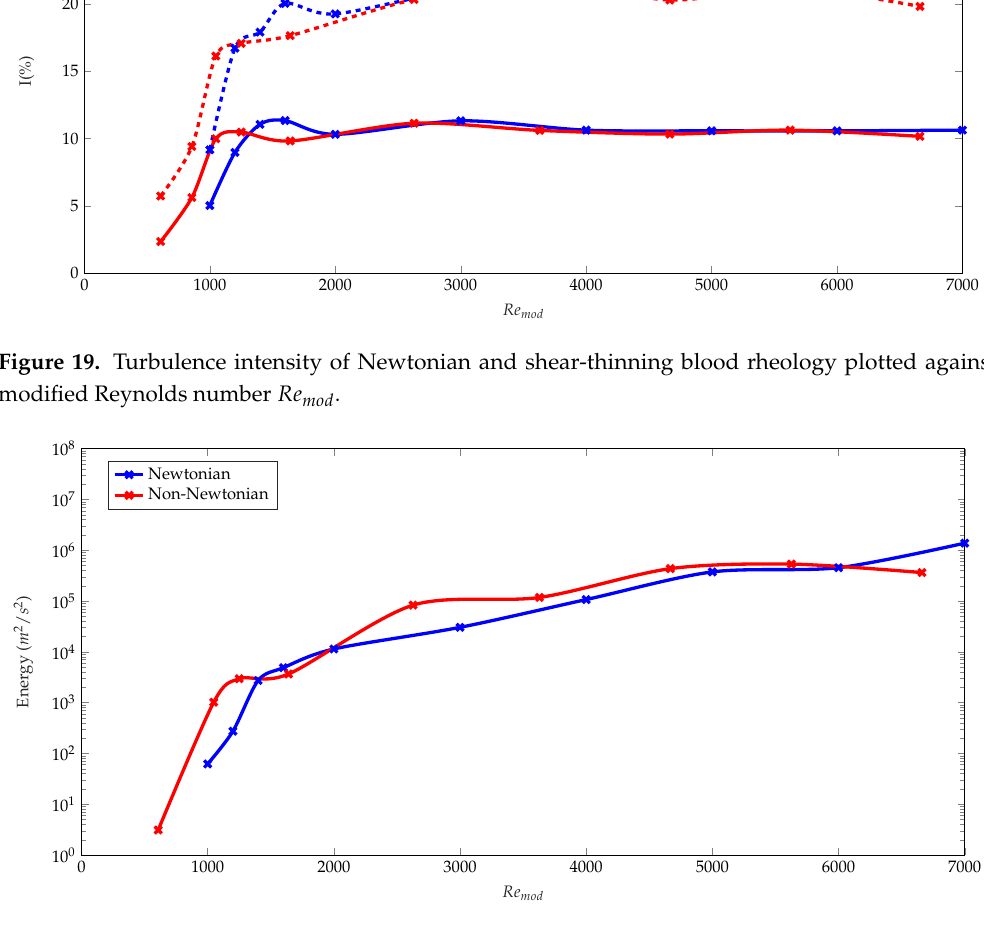
Figure 20. Mean energy frequency of Newtonian and shear-thinning blood rheology plotted against modified Reynolds number Re mod .